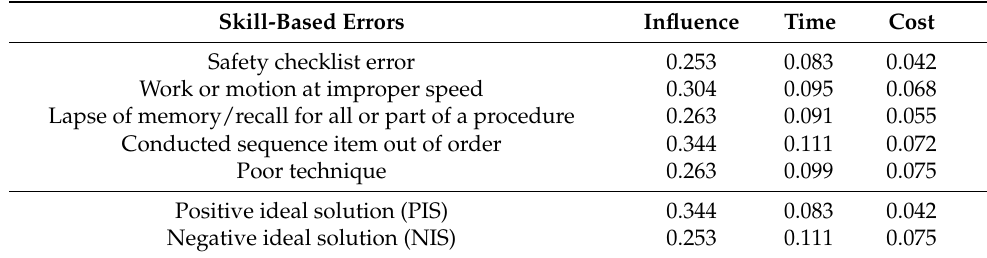
Table 5. Weighted and normalized decision matrices with the PIS and NIS of “skill-based